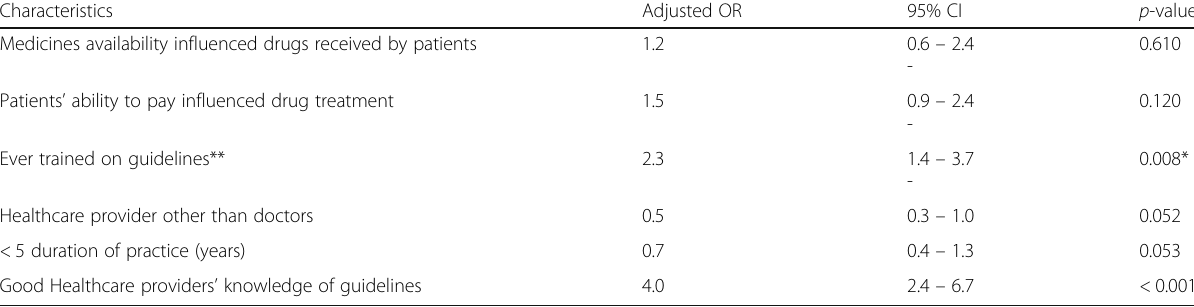
Table 5 Predictors of Preference for ACT among healthcare providers, Lokoja, North-Central Nigeria